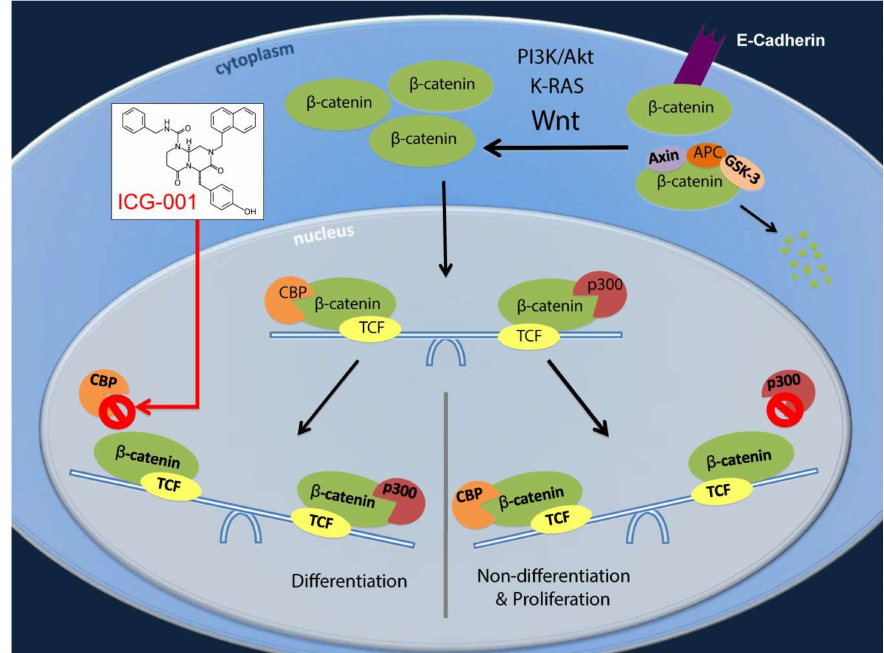
Figure 6. ICG-001 specifically blocks the CBP/ β -catenin interaction. As a result, there is a shift from CBP/ β -catenin pathways, which effect the proliferation/potency (non-differentiation) transcriptional program, to p300/ β -catenin pathways, which effect the differentiation transcriptional program (with loss of stemness). ICG-001 modulates crosstalk between Wnt/ β -catenin and K-Ras signaling pathways which converge at the level of CBP/ β -catenin versus p300/ β -catenin interaction. Thus, ICG-001 can sensitize pancreatic cancer to conventional therapy, via suppression of survivin, induction of let-7a, and eradication of highly drug-resistant tumor-initiating